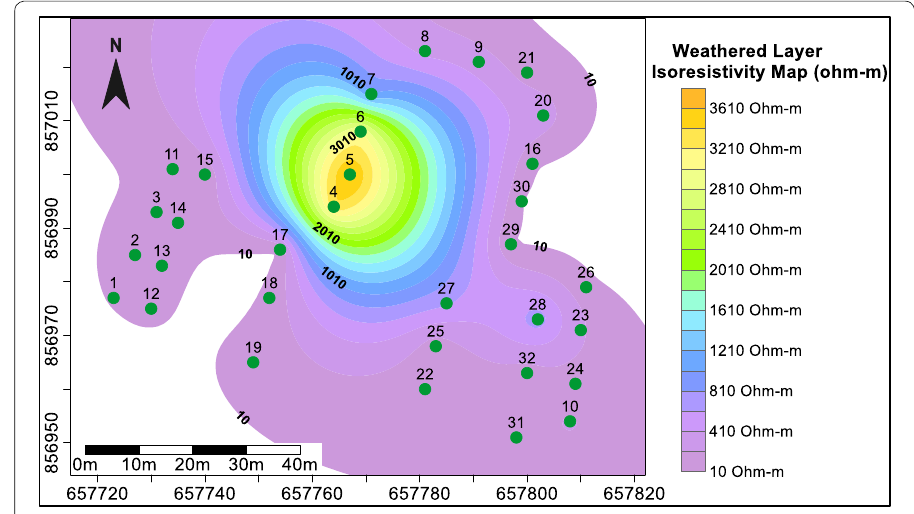
Fig. 16 Isoresistivity map of the weathered layer